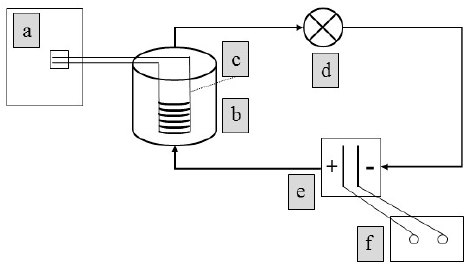
Figure 1. Scheme of electrolysis setup; a: chiller; b: tank; c: cooling coil; d: peristaltic pump; e: electrolytical cell; f: power supply .